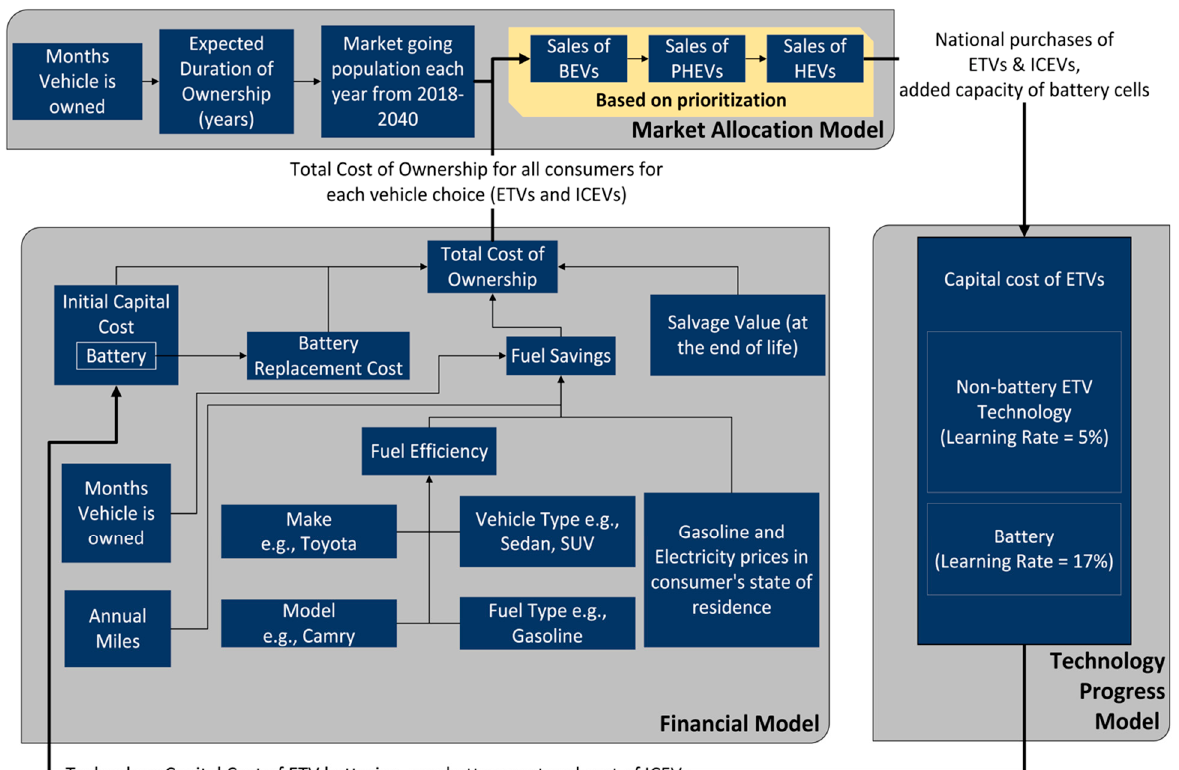
Figure 1. Method to model future prices and adoption of Battery Electric Vehicles (BEVs), Plug-in Hybrid Electric Vehicles (PHEVs), Hybrid Electric Vehicles (HEV), and Internal Combustion Engine Vehicles (ICEVs), in the U.S. from 2018 to 2040. The three sub-models are the Financial Model, the Market Allocation Model, and the Technology Progress Model, which are run in annual loops: